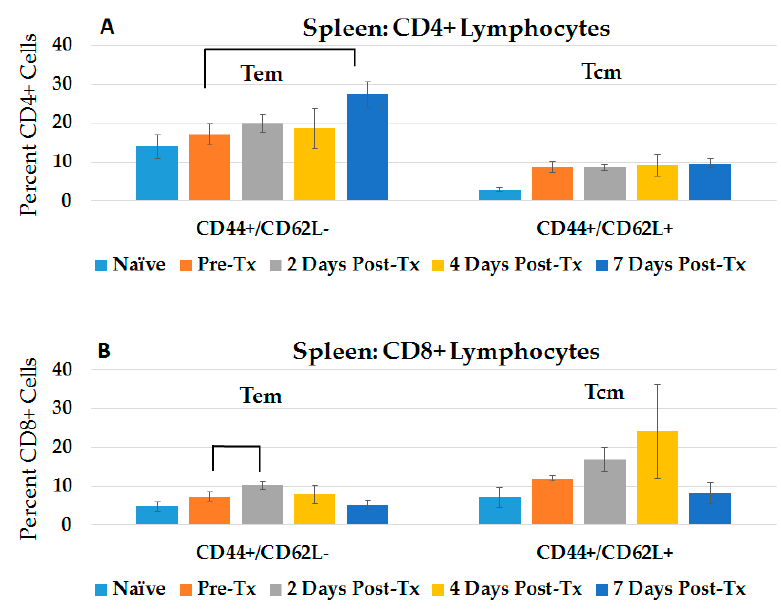
Figure 2. NPS induces increases in splenic CD4+ Tem and CD8+ Tem and Tcm after treatment. Lymphocytes were isolated from spleens at various times post-treatment, then stained with CD4, CD8, CD44 and CD62L; analysis was done on CD4+ cells ( A ) and CD8+ cells ( B ). Error bars = standard error of the mean (SEM); Naïve, 2 Days, 4 Days n = 4; Pre-Tx n=2; 7 Days n = 5. A. CD44+/CD62L − 7 Days Post-Tx: p = 0.02. B. CD44+/CD62L+ 2 Days Post-Tx: p < 0.004; connecting lines p < 0.05.